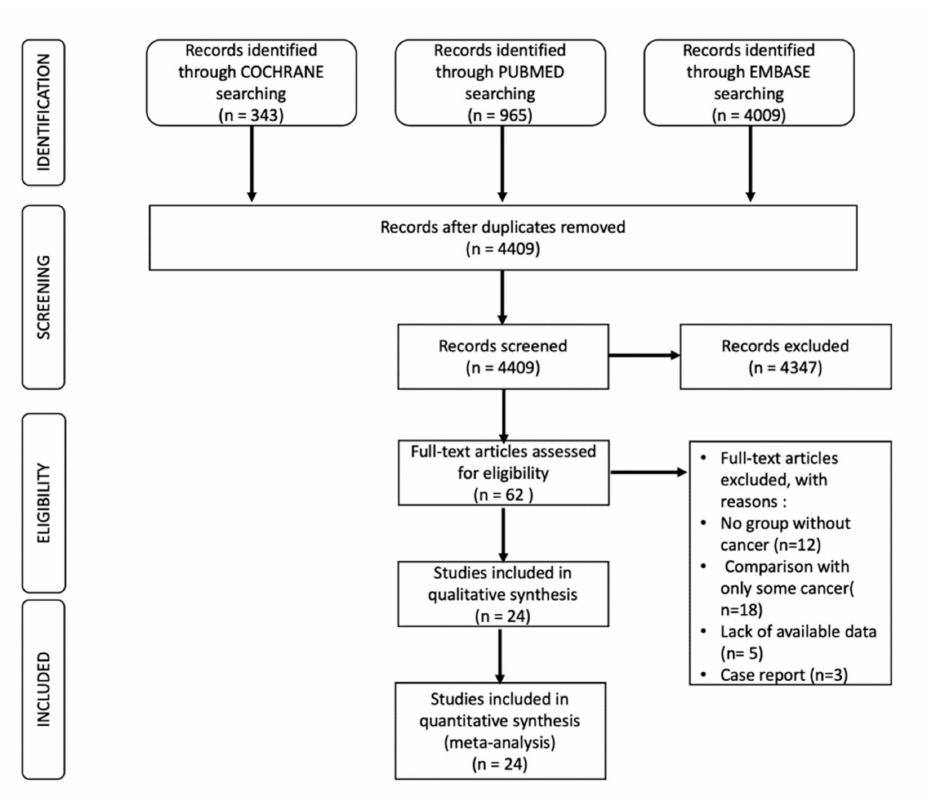
Figure 1. Flow Diagram Illustrating Study Selection